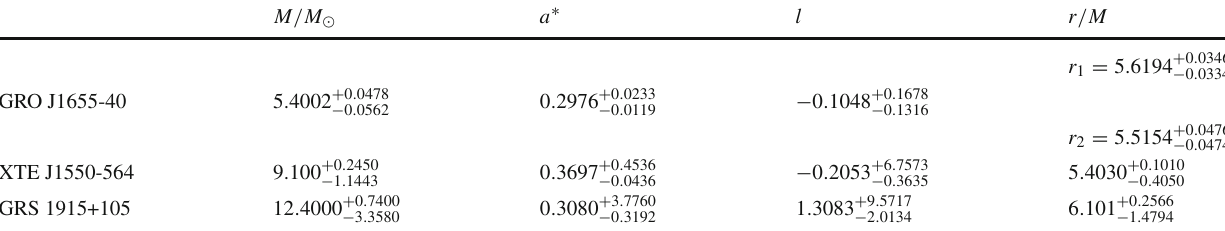
Table 2 Best-fit values and their range of 1 σ for the black hole parameters with the metric (4) from GRO J1655-40, XTE J1550-564, and GRS 1915+105, respectively M / M (cid:13) a